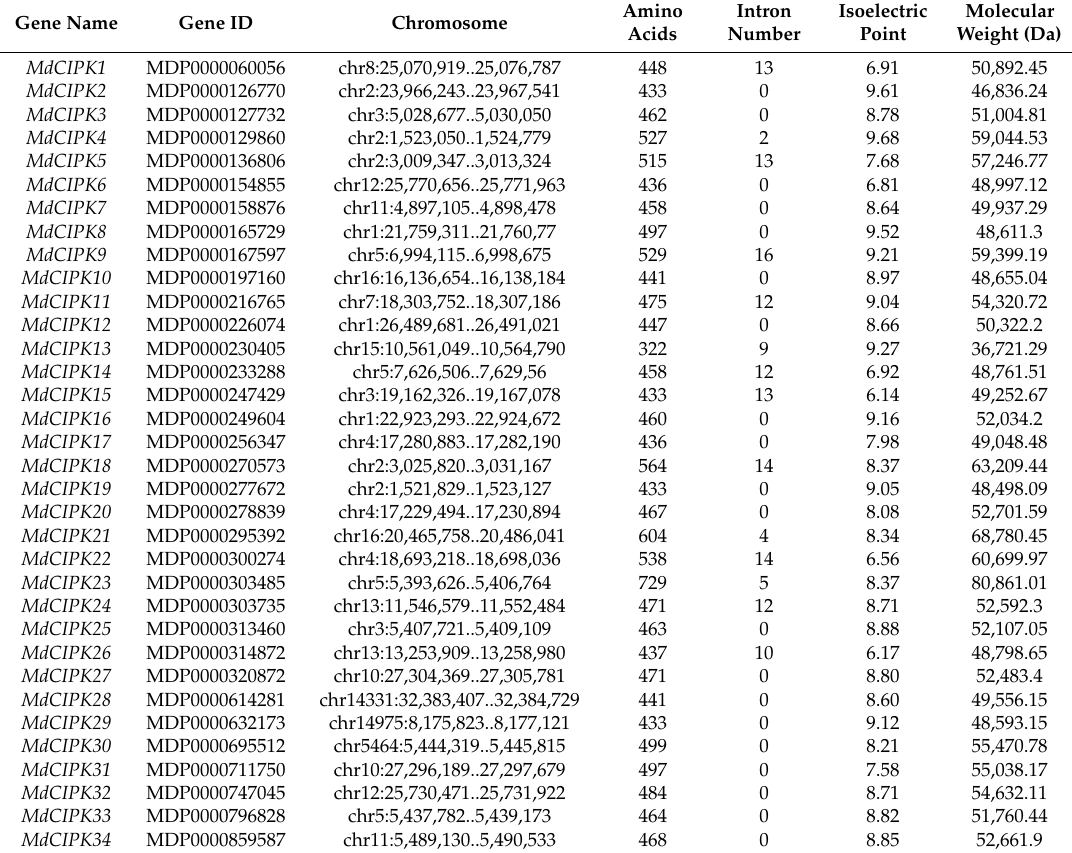
Table 1. The characteristics of CIPK family members in